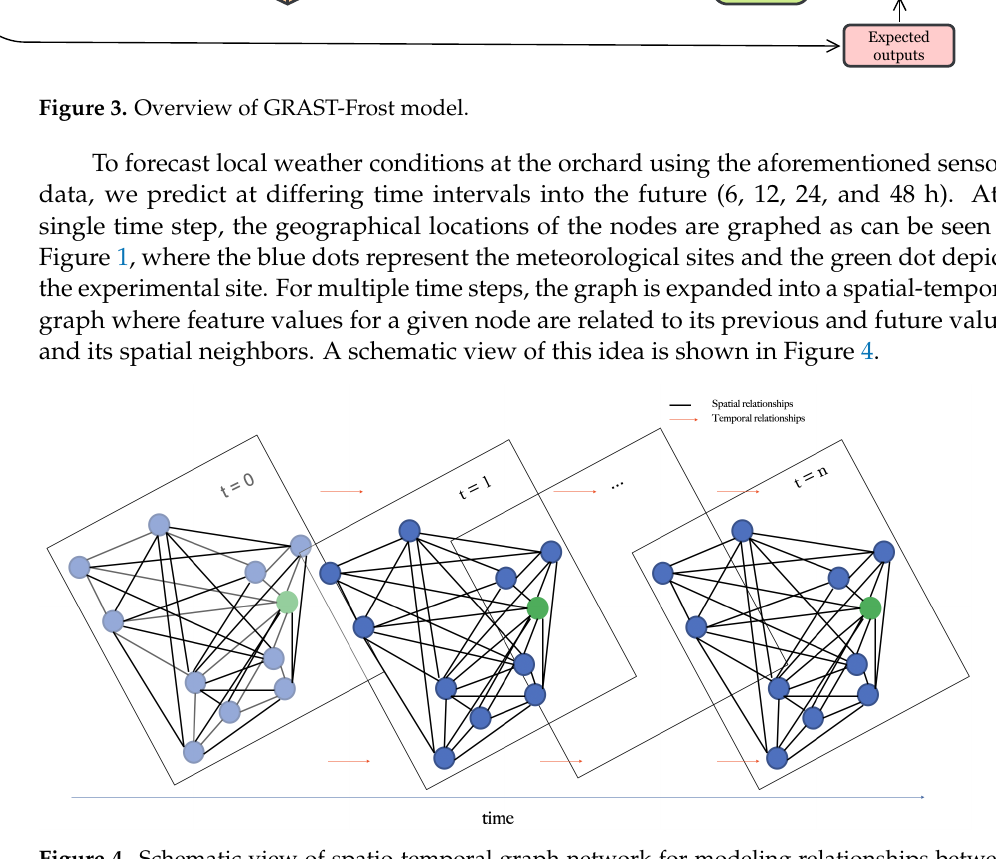
Figure 4. Schematic view of spatio-temporal graph network for modeling relationships between experimental field and weather stations through